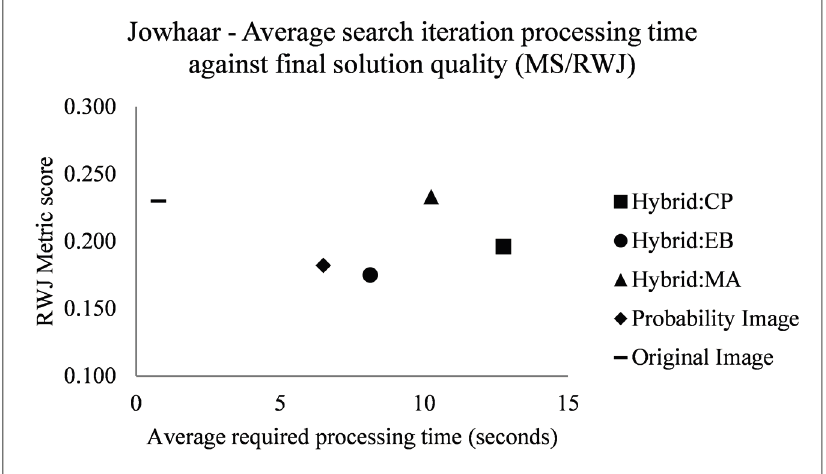
Figure 16. Search iteration execution time profiling for the Jowhaar problem